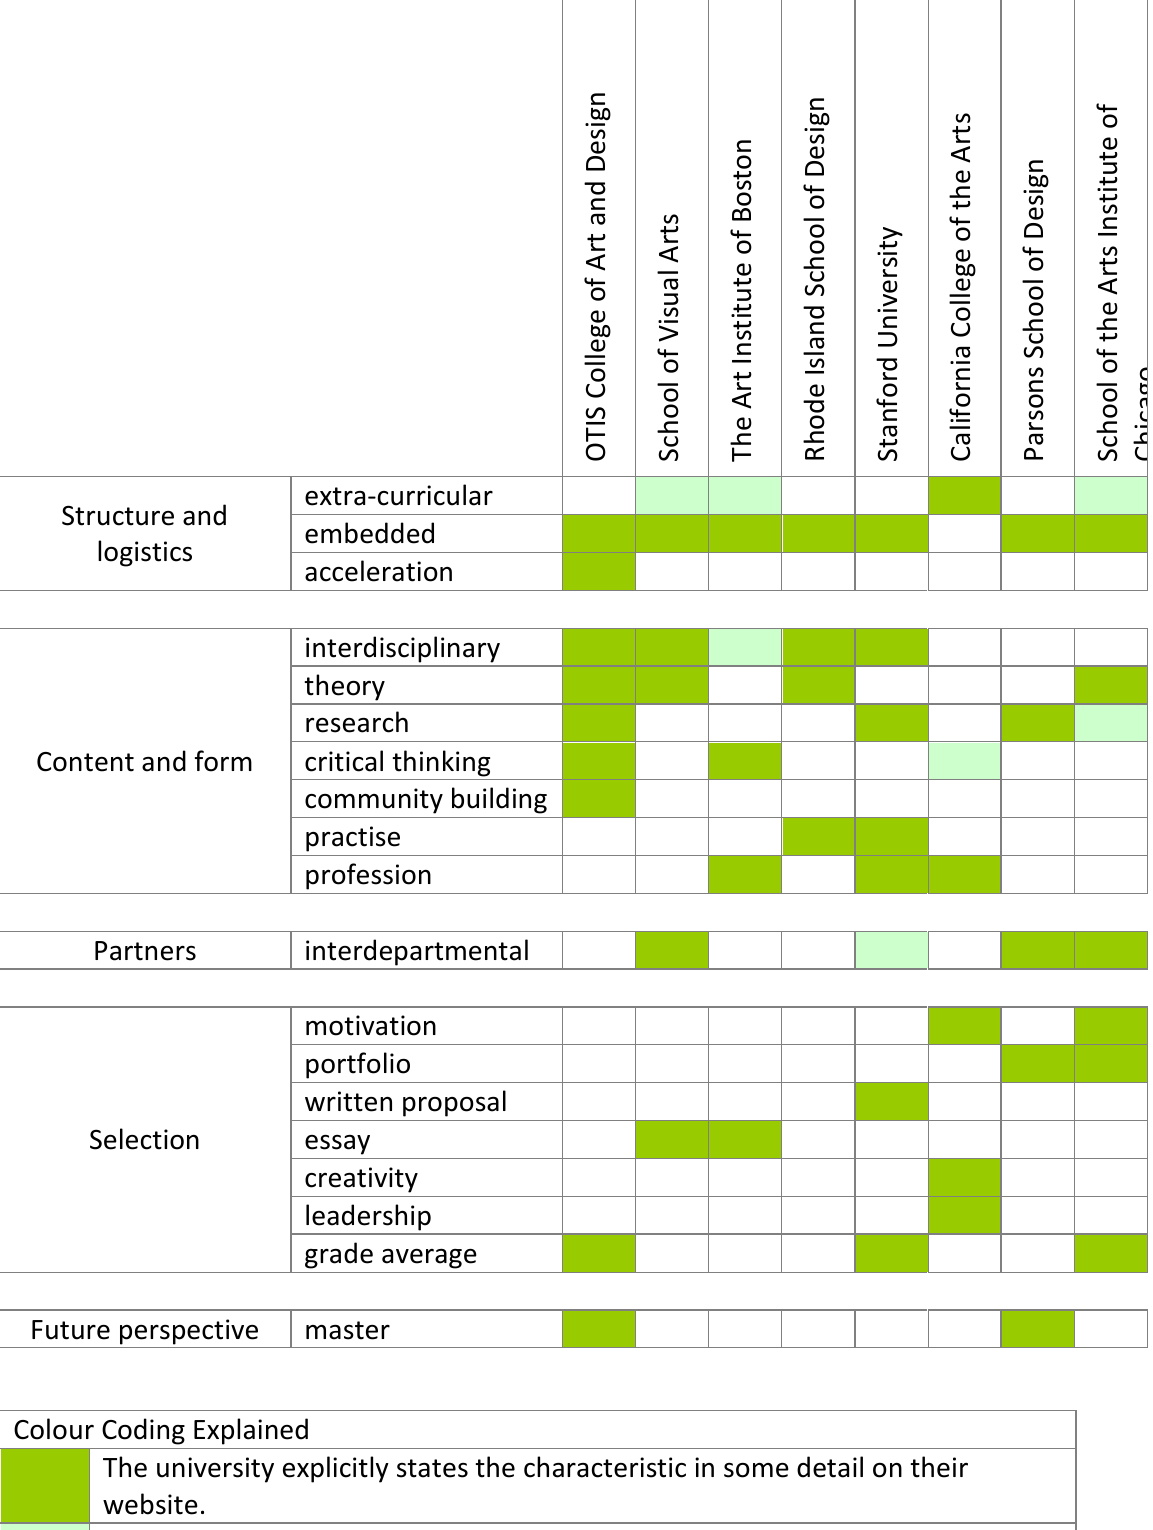
Table 3: Profile of Honours Programmes at American Universities for the